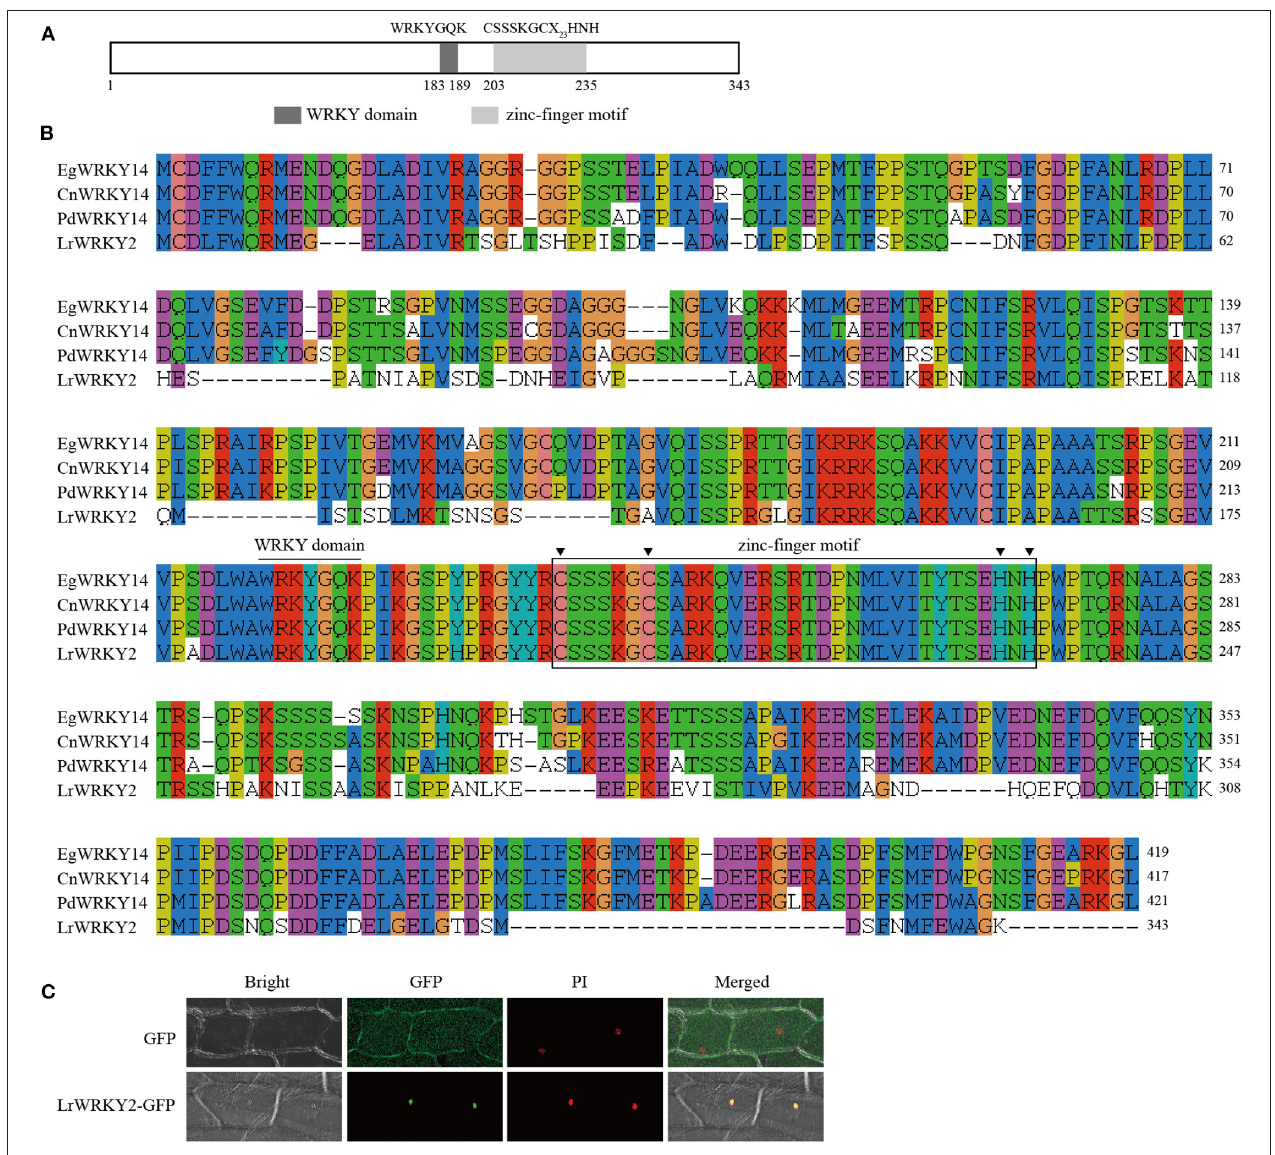
FIGURE 1 | The sequence and subcellular localization analyses of LrWRKY2. (A) The conserved domains predicted in the LrWRKY2. (B) The multiple alignment of the amino acid sequence of LrWRKY2 and three homologous WRKYs were performed with the ClustalW. (C) Subcellular localization analysis of LrWRKY2-GFP fusion protein. The LrWRKY2-GFP fusion protein was transiently expressed in nucleus after genetic transform mediated by Agrobacterium tumefaciens . GFP, fluorescent light; Bright, white light; PI, the nucleus was displayed by propidium iodide (PI) staining; Merged, overlaid of fluorescent and the nucleus displayed by PI staining.